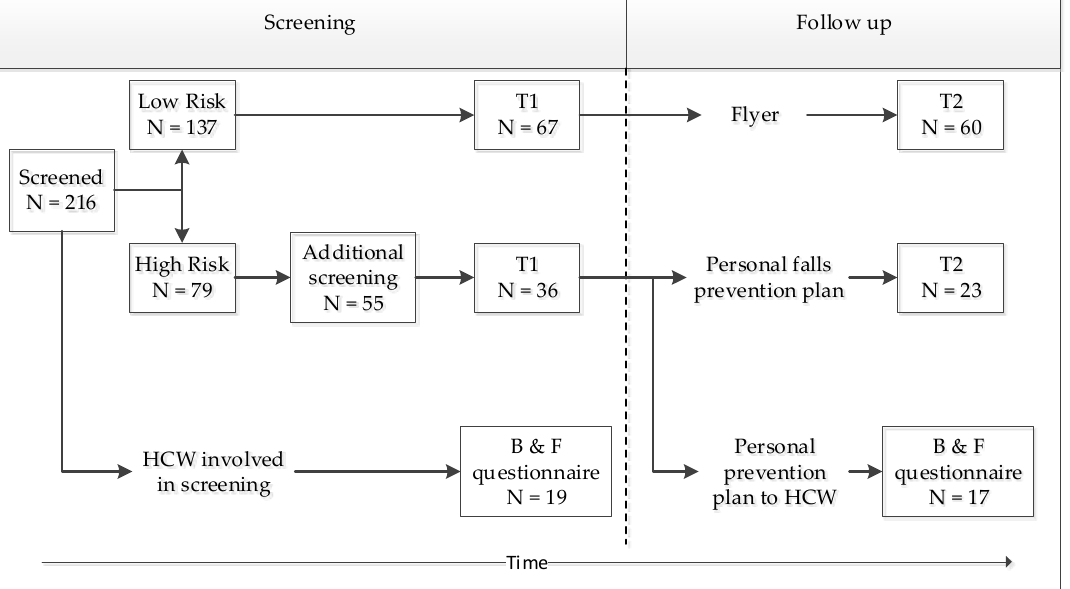
Figure 1. Flowchart of fall risk screening and follow-up. Abbreviations: HCW = healthcare worker; T1 = first questionnaire for patients, which included sociodemographic characteristics and barriers and facilitators; T2 = second questionnaire for patients to assess perceptions about falls and fall prevention; B & F = barriers and facilitators questionnaire for healthcare workers.